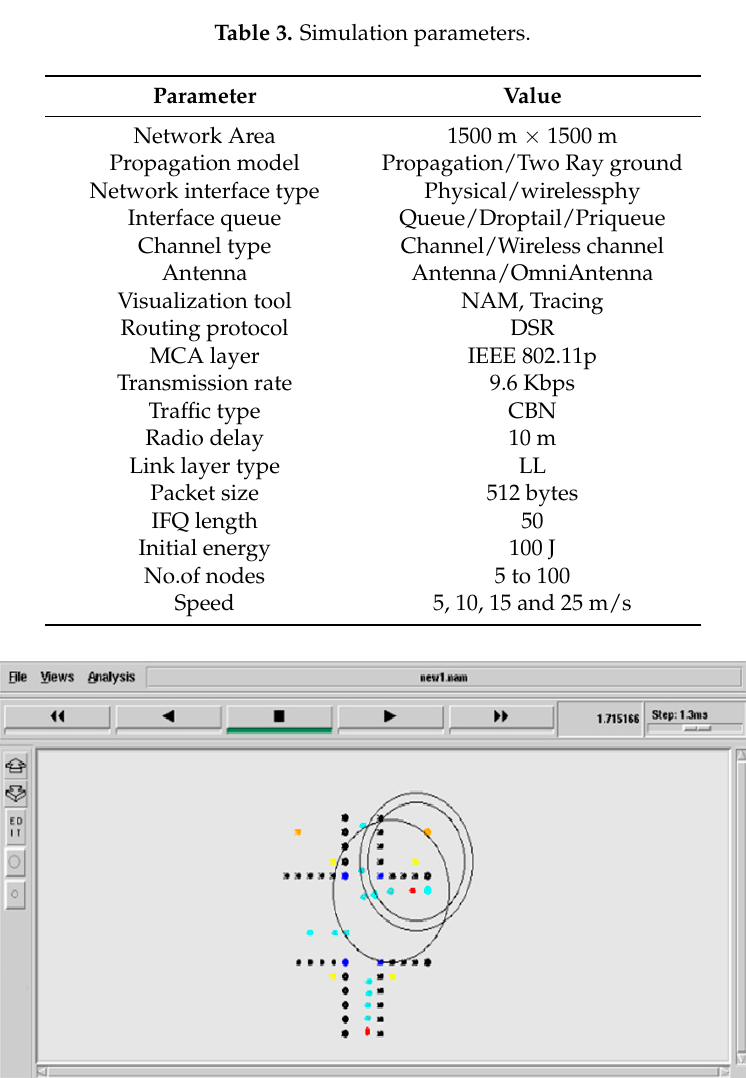
Figure 7. NAM of VANET simulation. Table 3. Simulation parameters.